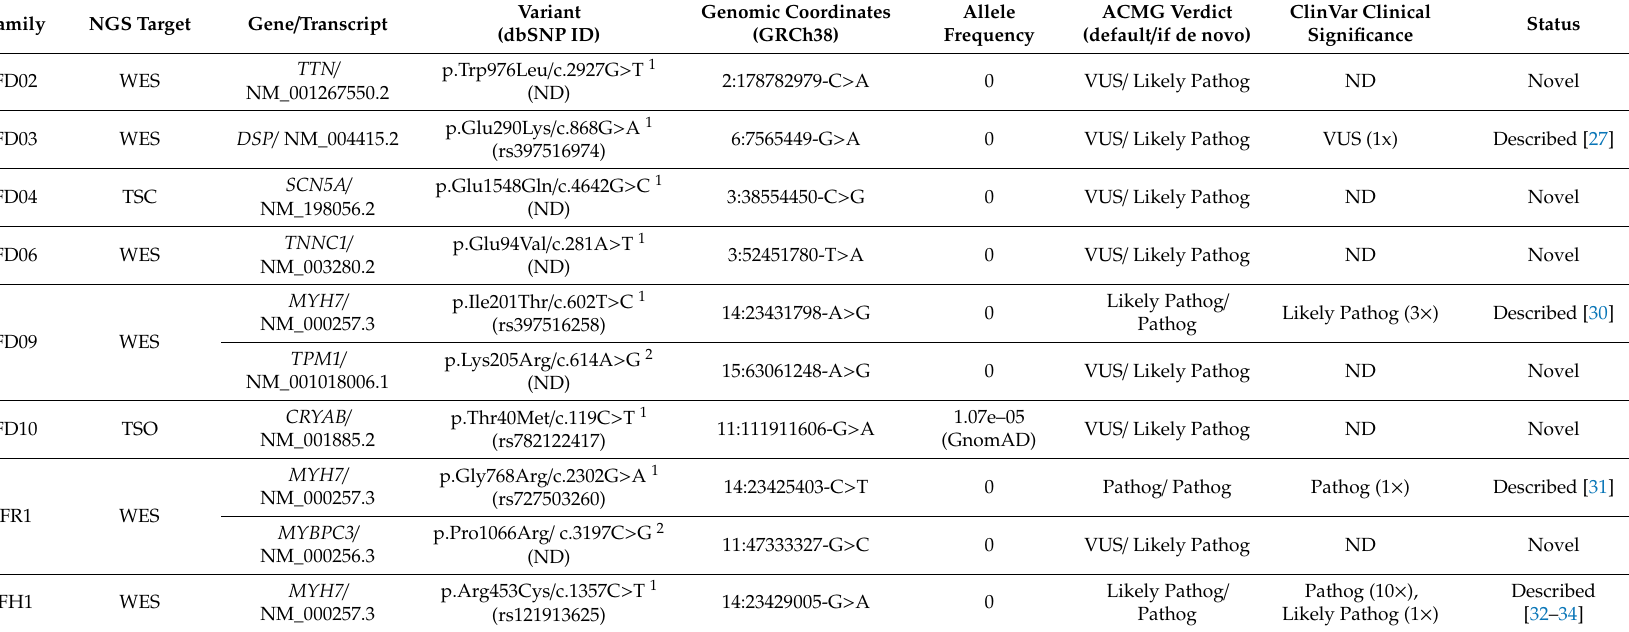
Table 1. Molecular characteristics of variants of interest in known cardiomyopathy genes found in